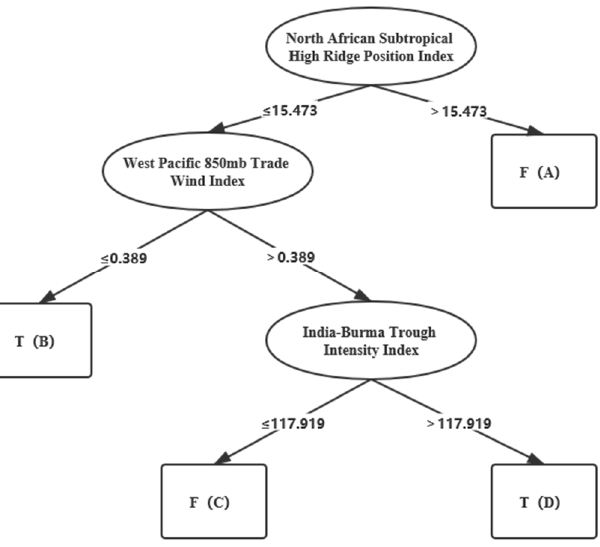
Figure 7. The classification tree model derived for cluster1 of the Poyang Lake basin.